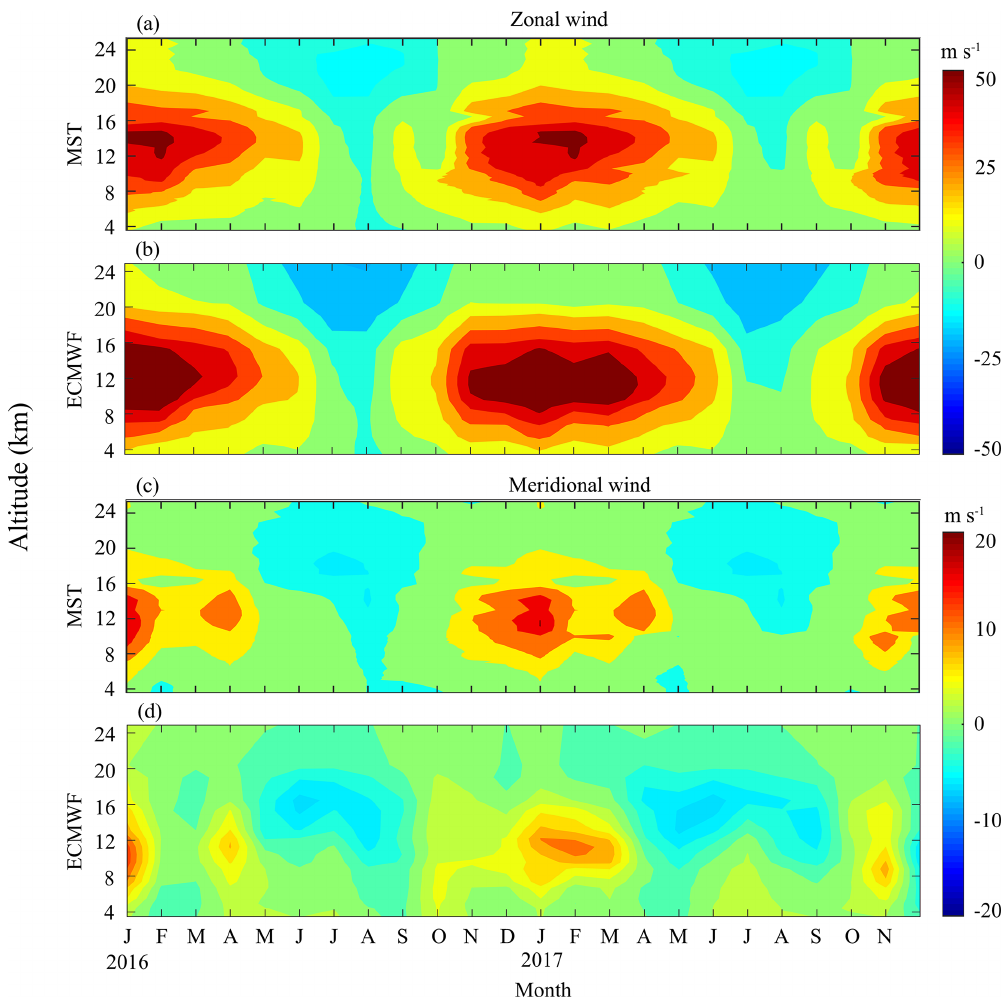
Figure 10. The contour plots of the monthly mean zonal (a) and meridional (c) winds in the troposphere and low stratosphere observed by the Wuhan MST radar during January 2016–December 2017. ERA-Interim model-estimated monthly mean zonal (b) and meridional (d) winds for the Wuhan region during the same